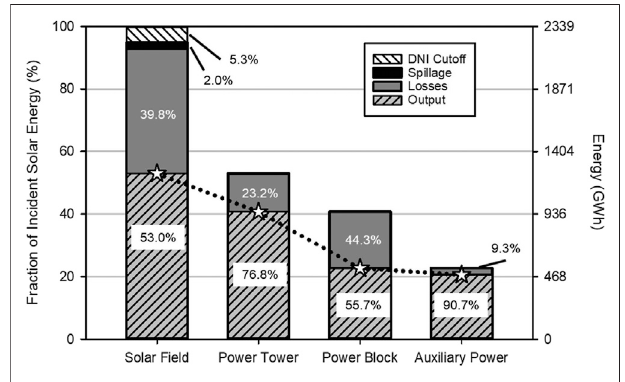
FIGURE 4 | Annual average energy ef fi ciency from incident solar to electricity applying tmy3